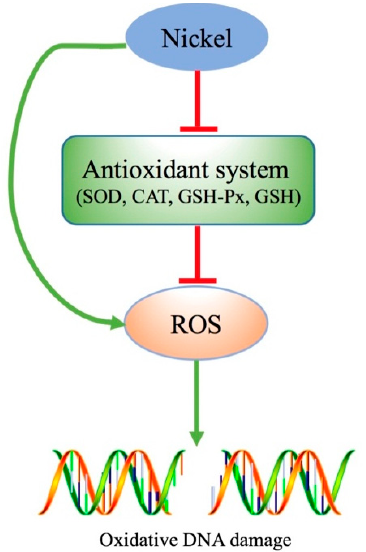
Figure 1. Ni induced reactive oxygen species (ROS) accumulation. Excessive exposure of Ni can increase ROS accumulation through directly increasing ROS generation and through an antioxidant system suppression, which then damages the